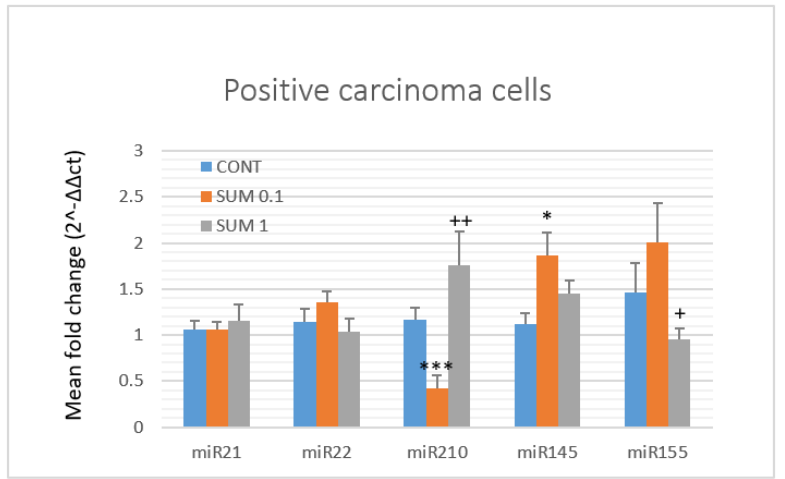
Figure 7. Relative miRNA expression of miR21, miR22, miR34a, miR210, miR145, and miR155 in